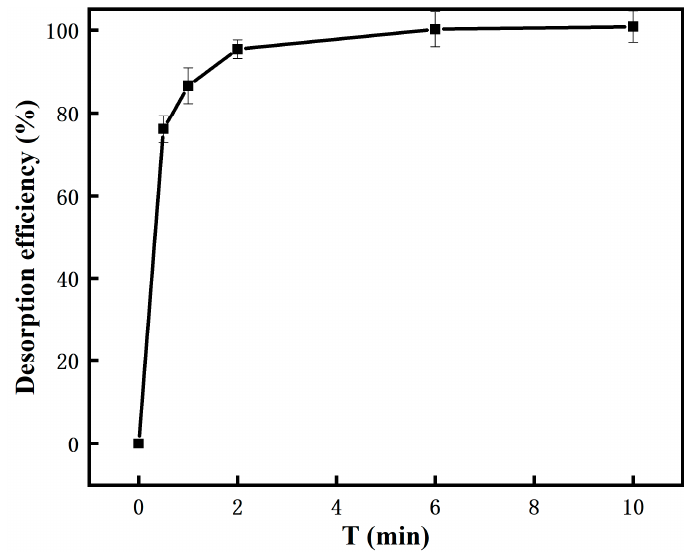
Figure 7. Desorption kinetics of Cu (II).